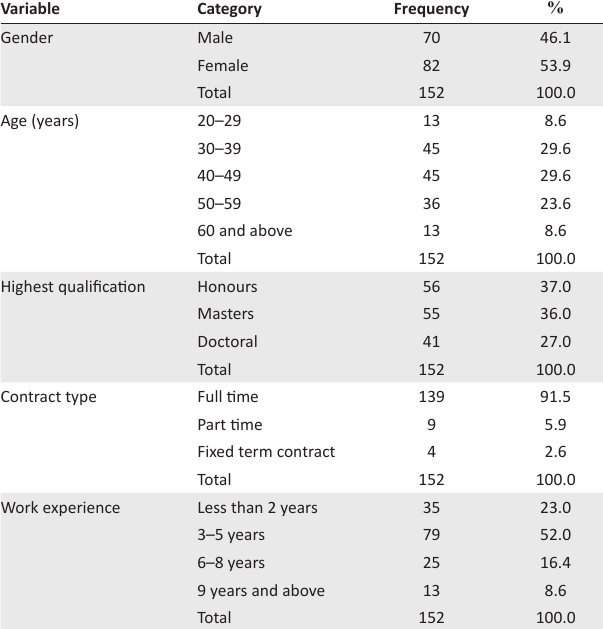
TABLE 1: Demographic information ( N =